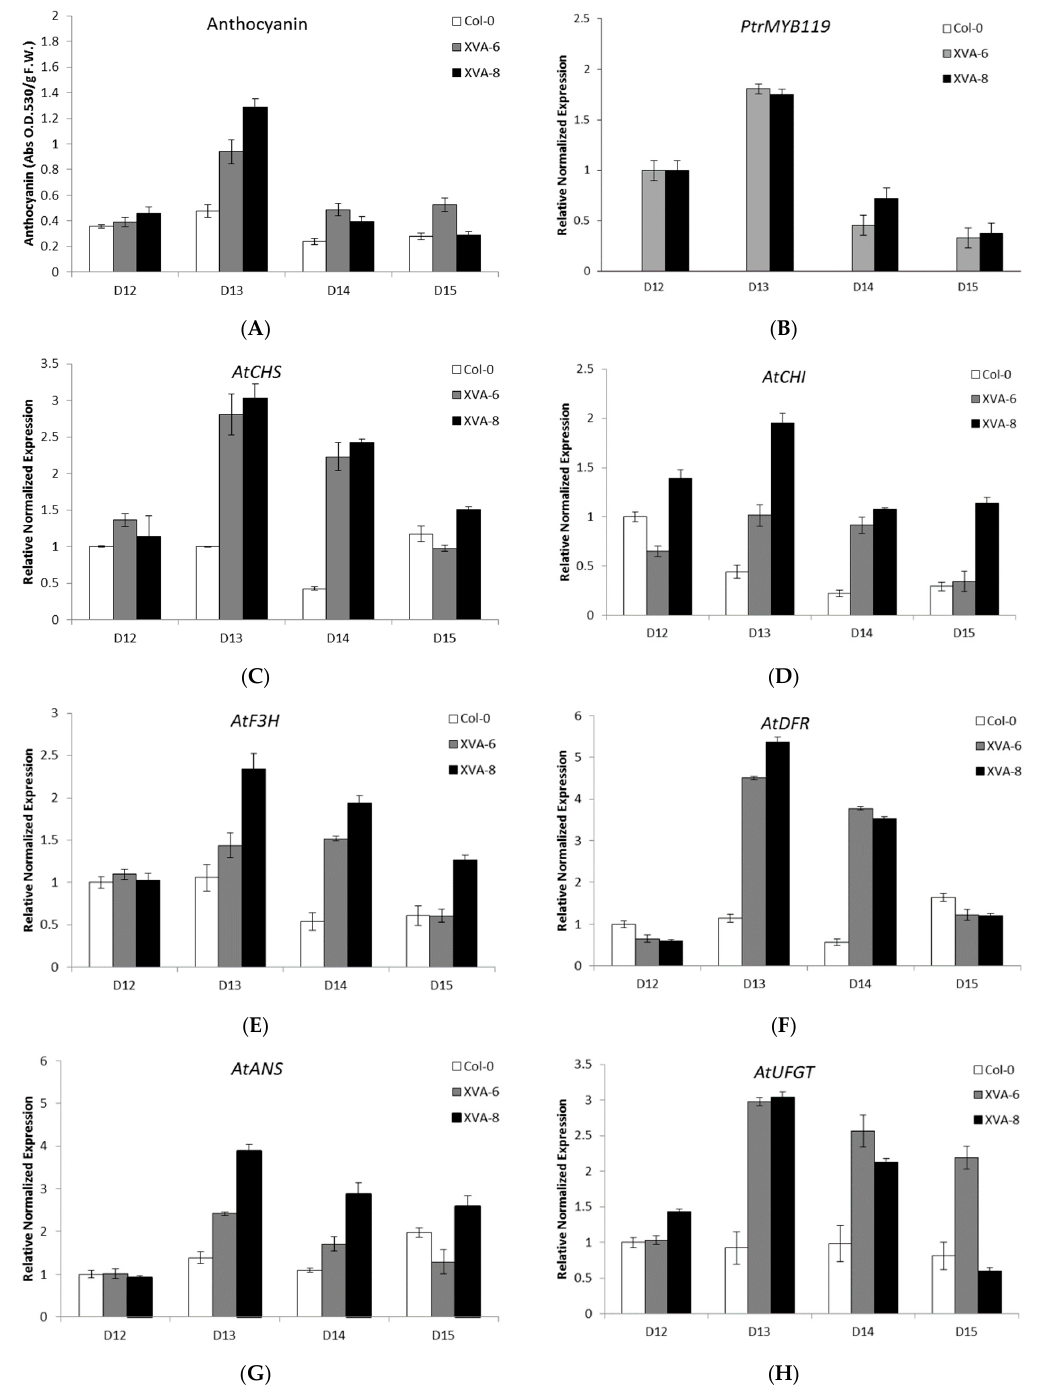
Figure 4. Time course experiments showing the anthocyanin content and the expression levels of anthocyanin biosynthesis genes in wild ‐ type (Col ‐ 0) and transgenic Arabidopsis plants. ( A ) Anthocyanin contents in wild ‐ type (Col ‐ 0) and transgenic Arabidopsis . The seeds were germinated on 1 / 2 MS agar medium containing 10 ppm DHT and grown for 15 days. ( B – H ) The transcript level of anthocyanin biosynthesis genes was analyzed by qRT ‐ PCR. AtActin2 was used as an internal control. Experiments were performed using seedlings at 12–15 days after seed germination (D: day). All experiments were performed in triplicate, and the average is represented in the graphs.